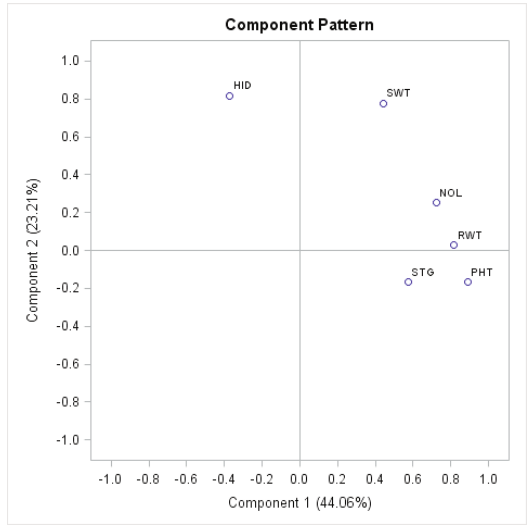
Fig. 1 ­ Principal component loading pattern of six traits of Amaranthus accessions.